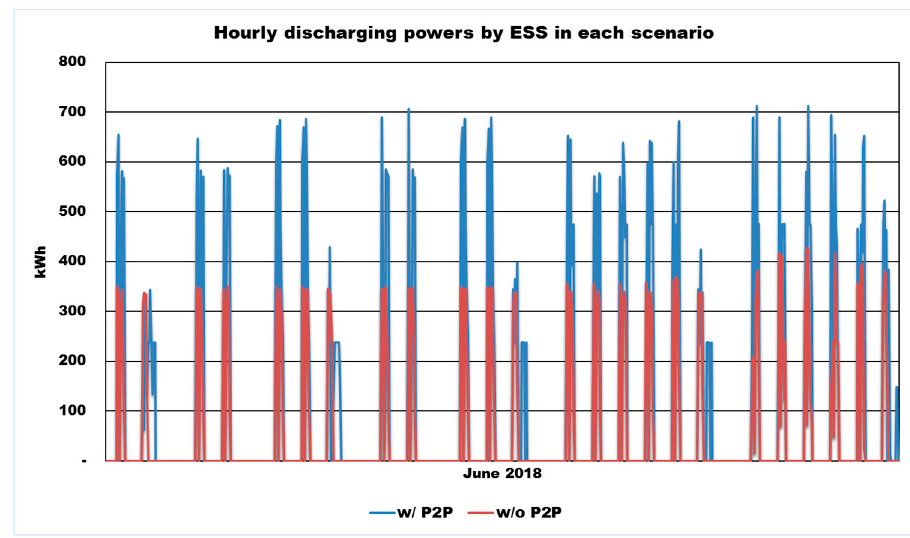
Figure 11. Comparison of hourly discharging powers by ESS in each scenario.